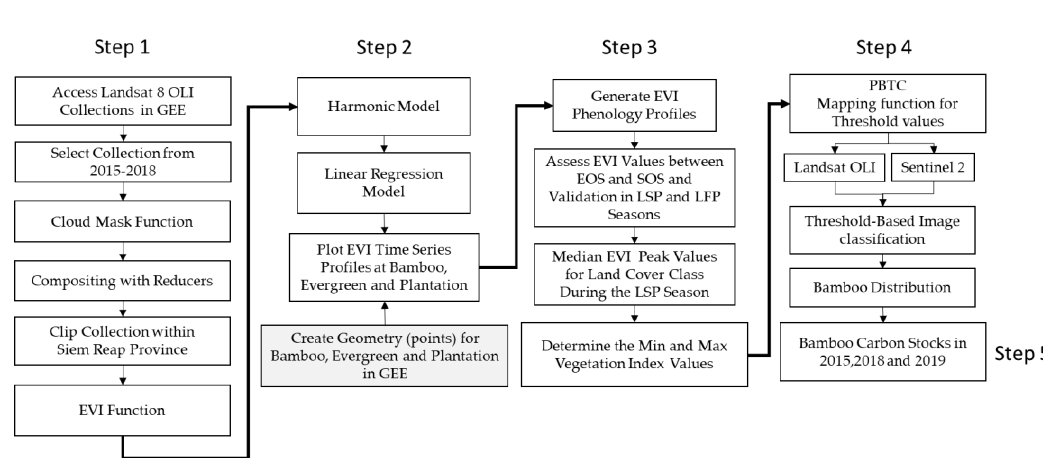
Table 2. Landsat OLI and Sentinel-2 image collections used in this study for phenology-based threshold classification (PBTC).